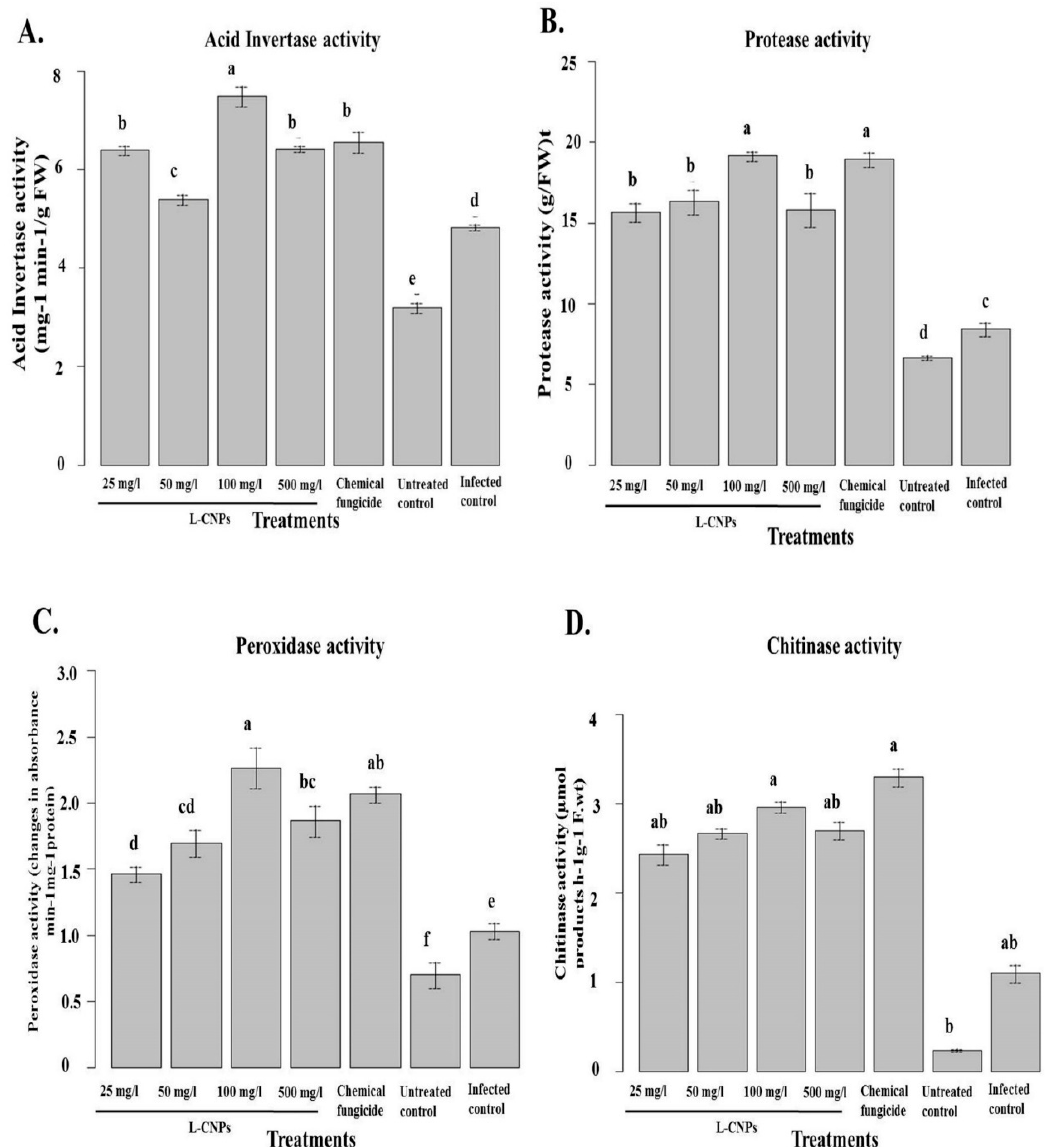
Figure 8. Effect of the treatment with L-CNPs on the defense-related enzymes in maize leave samples compared to the chemical fungicide and the untreated controls. (L-CNPs25, L-CNPs50, L-CNPs100, and L-CNPs500) refer to L-CNPs concentrations applied to the seed for priming. The values were recorded on seedlings at 14 DAS. ( A ) Acid invertase activity; ( B ) protease activity; ( C ) peroxidase activity, and ( D ) chitinase activity compared to the untreated control. Letters in the figure, if different, indicate statistically significant differences of p < 0.05 between treatments. These findings suggest that maize is more resistant to F. verticillioides infections when L-CNPs are applied exogenously. This is in line with other reports showing that some derived compounds applied exogenously can induce resistance in their hosts by increasing higher levels of host defense enzymes and pathogen-related (PR) proteins. This suggests that the L-CNPs induce systemic resistance in the host plants, which makes them less likely to get infected [79].